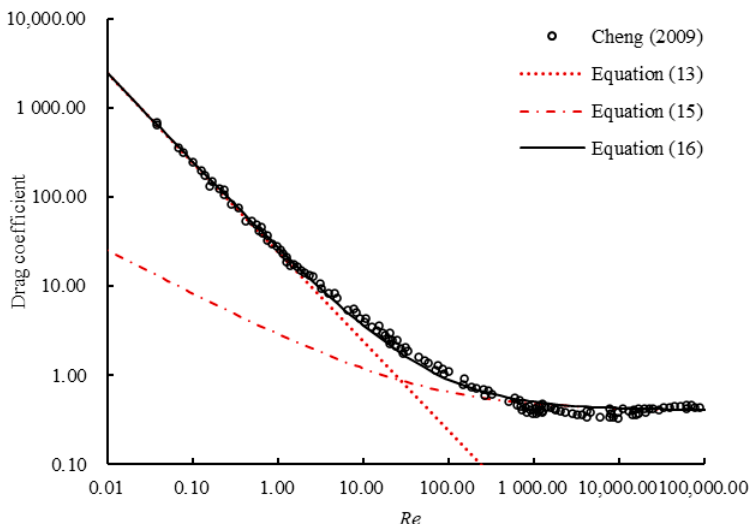
Figure 8. Variation in the drag coefficient against the Reynolds number [30].